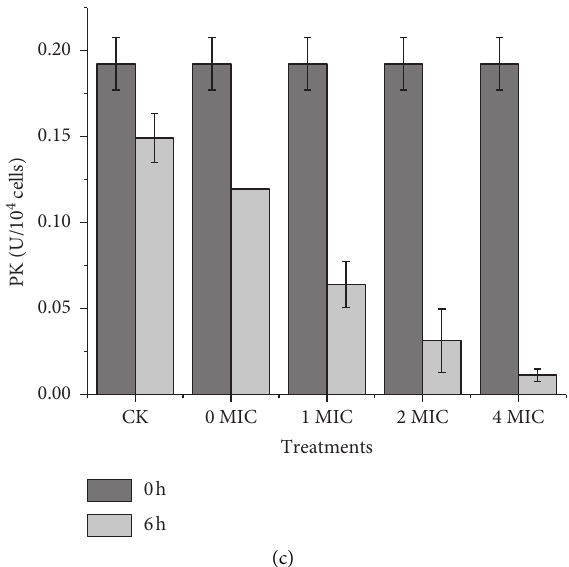
Figure 6: Effect of different concentrations of DMY in the EMP pathway on hexokinase (a), phosphofructokinase (b), and pyruvate kinase (c) in Pseudomonas